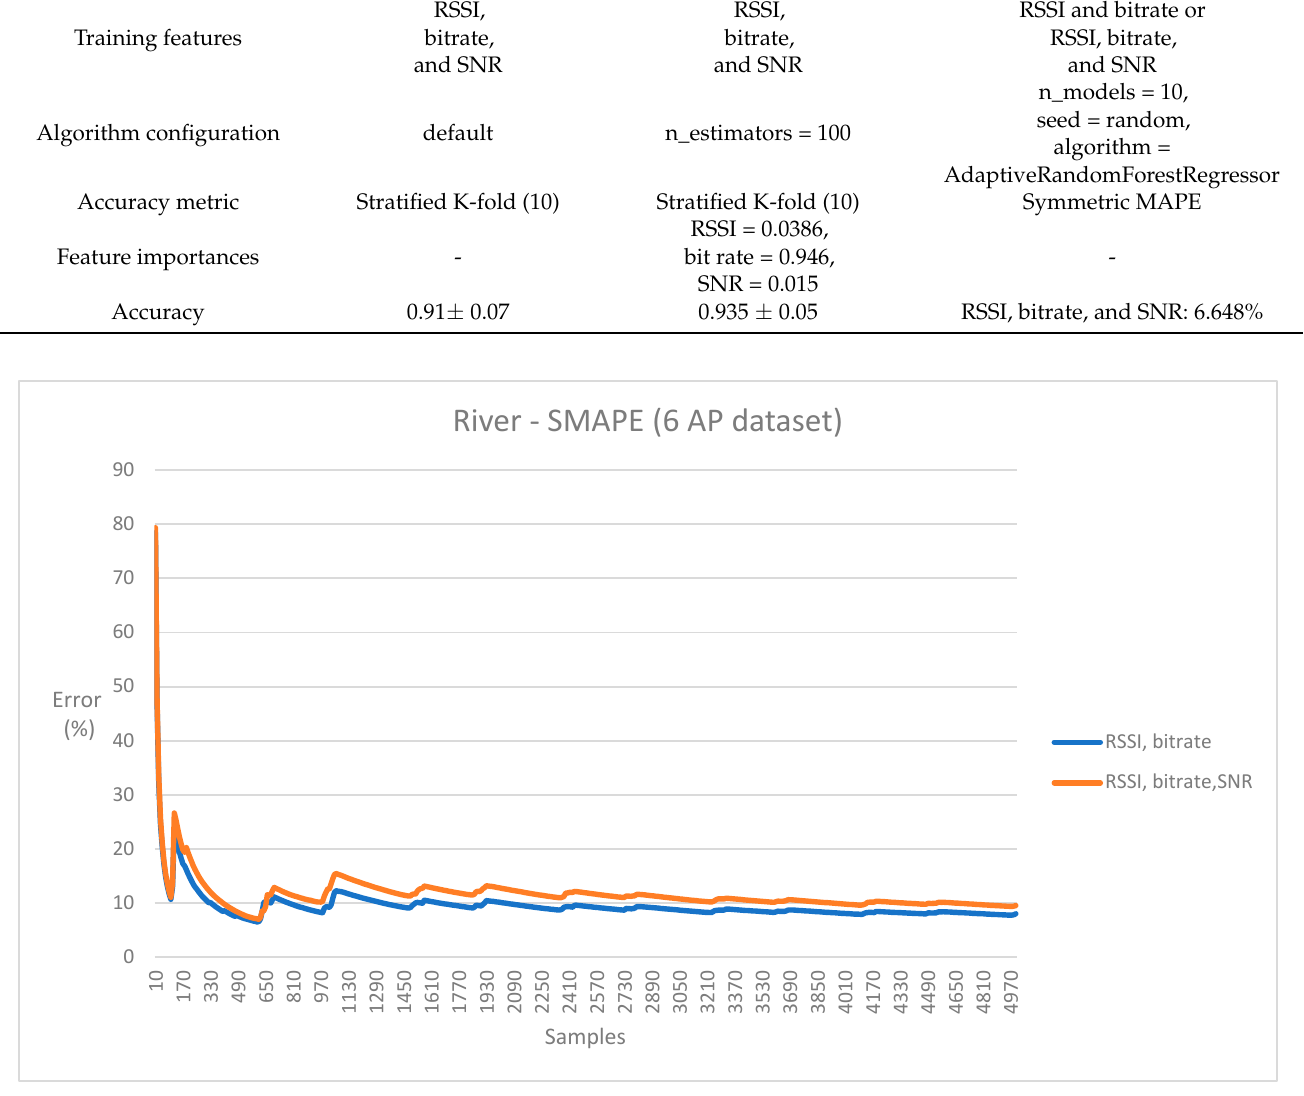
Figure 13. Error (symmetric MAPE) of incremental ML with River as a function of data samples. Measurements of the first 5000 samples are provided for illustrating until SMAPE was <10